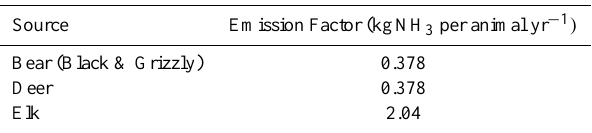
Table A5. CMU Ammonia Model v3.6 wild animal emissions fac-